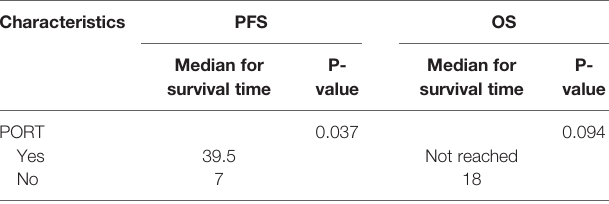
TABLE 7 | Comparison of the median survival time between patients with HGT and PORT and patients with HGT and no